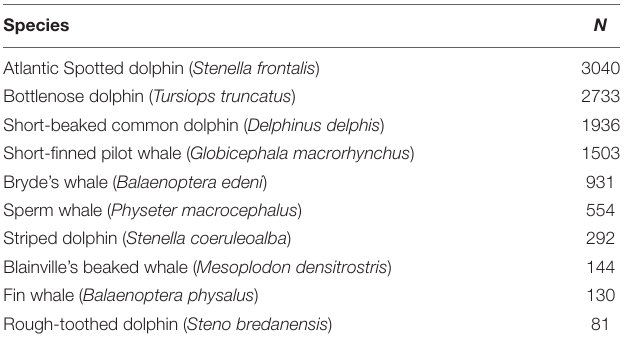
TABLE 1 | Number of sightings for the 10 most sighted species (out of 23) by commercial whale watching companies from 2003 until 2018 used in the present study ( n =